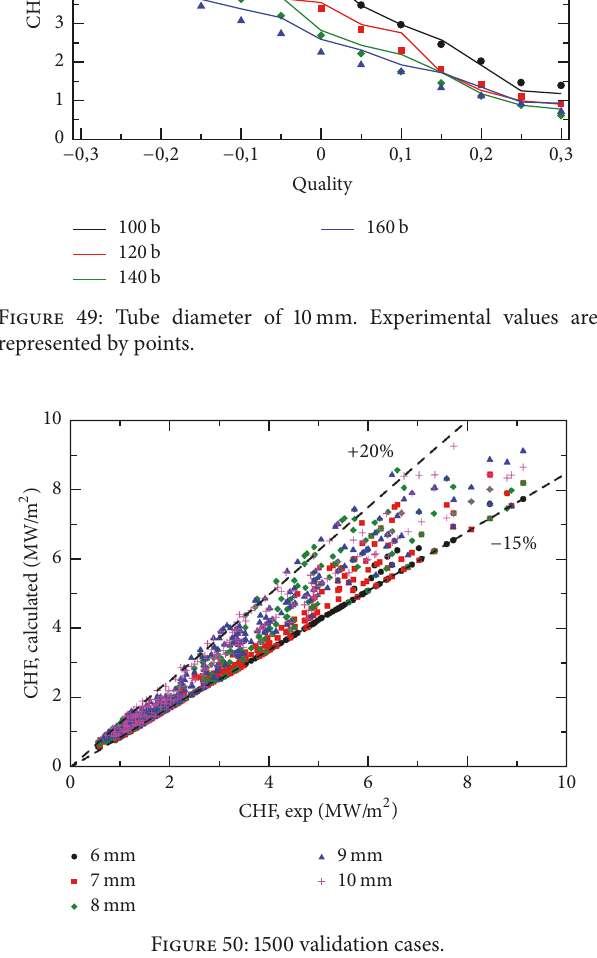
Figure 48: Tube diameter of 8mm. Experimental values are represented by points.